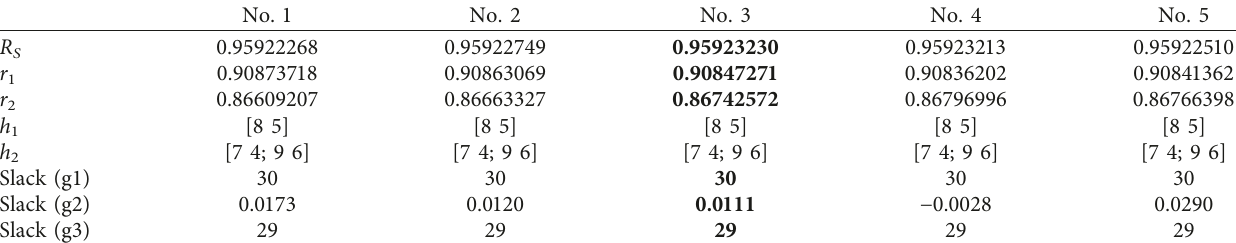
Table 7: Optimal component reliability and swapping strategy (Example 1).